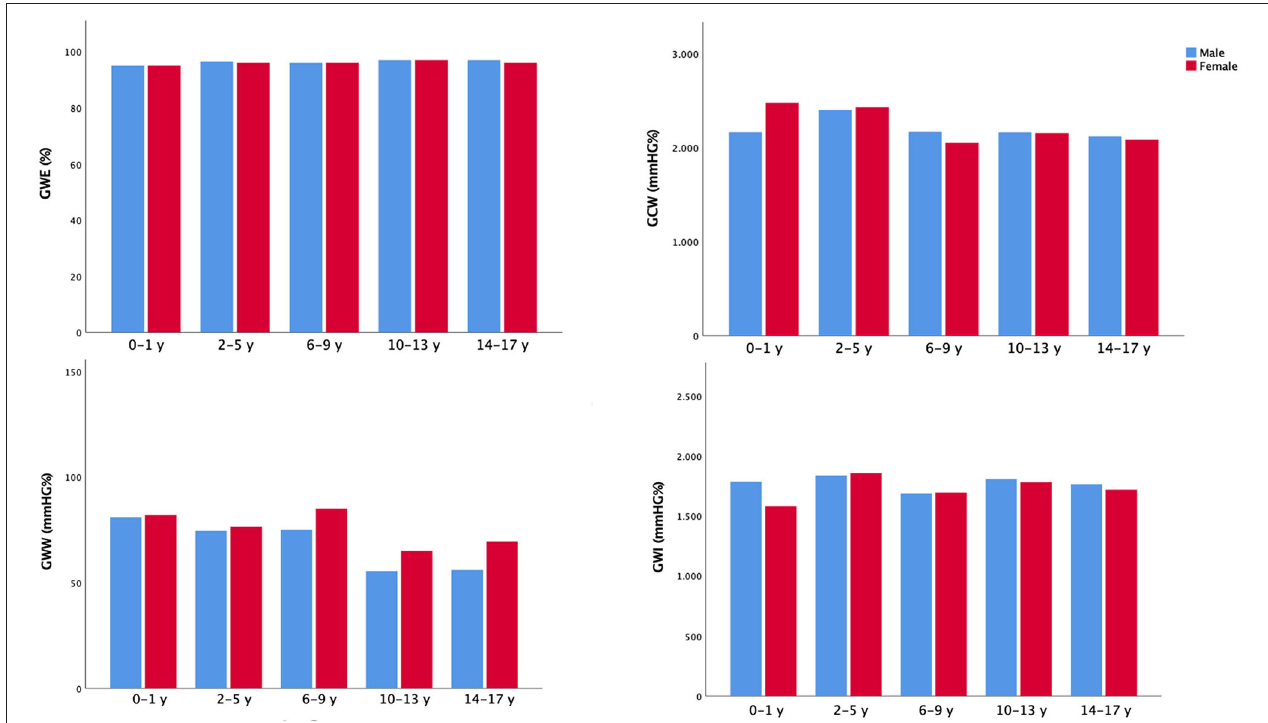
FIGURE 1 | Non-invasive myocardial work indices in the study population. Mean values of non-invasive myocardial work parameters according to gender and age categories.